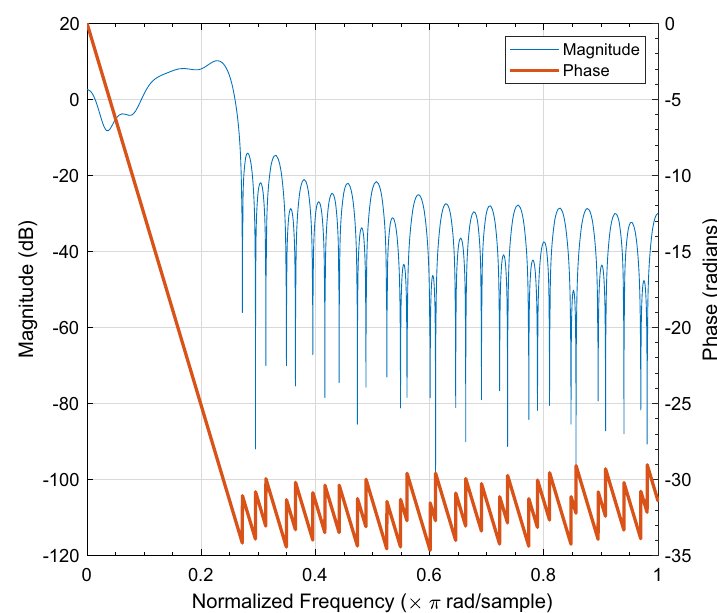
Fig. 6 Magnitude and phase responses of the filter f 2 depicted in Fig. 4